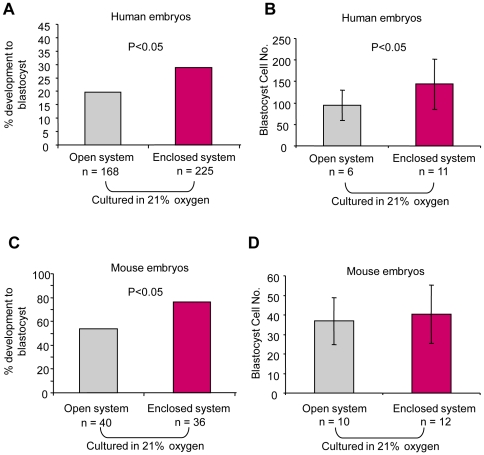
Effect of the enclosed system and 21% O2 tension on blastocyst development of embryos.(A) Development of human embryos to the blastocyst stage was significantly lower in the open system compared with the enclosed system when incubated in 21% O2; P<0.05. (B) Nuclear counts were performed to compare the total number of cells contained in human blastocysts cultured to day 6 in the open system or enclosed system in 21% O2. The cell count of human embryos cultured in the enclosed system in 21% O2 was significantly higher compared with those cultured in the open system (P<0.05). (C) A significantly higher proportion of mouse embryos developed from the 1 cell to the blastocyst stage in the enclosed system compared with the open system (P<0.05). Both sets of embryos were cultured in 21% O2. (D) Nuclear counts were performed to compare the total number of cells contained in mouse blastocysts cultured in the open system or enclosed system in 21% O2. The cell count of mouse embryos cultured in the enclosed system in 21% O2 was not significantly different compared with those cultured in the open system.